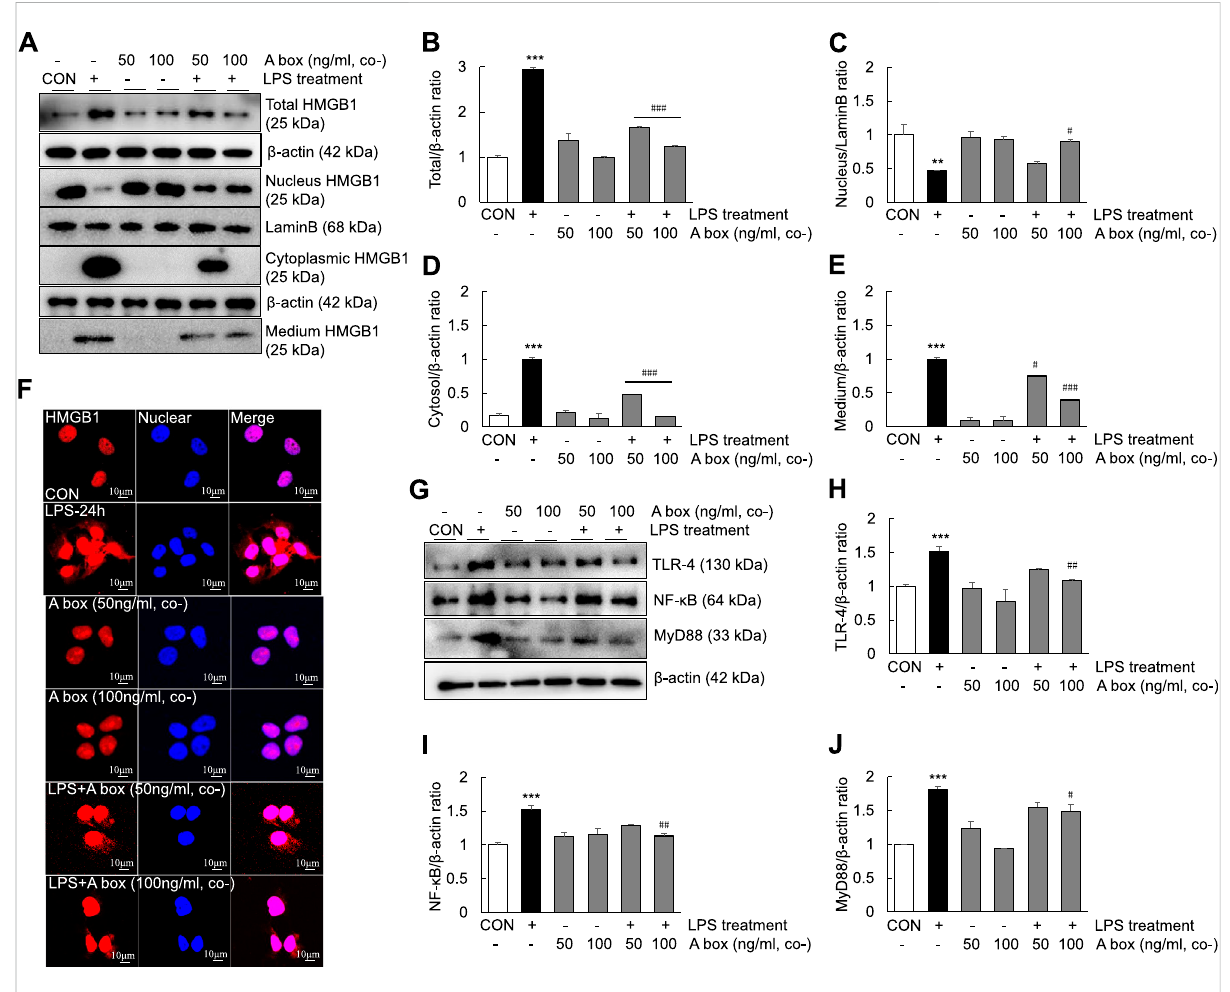
FIGURE 8 Suppression of the extracellular release of HMGB1 and TLR-4/NF- κ B signaling in LPS-induced Huh7 cells following HMGB1-A box treatment. Huh7 cells were treated HMGB1-A box (50 and 100 ng/ml) only for 24 h without LPS treatment and LPS (1000 ng/ml) for 24 h with or without HMGB1-A box (50 and 100 ng/ml). Western blotting was performed to determine the total, nuclear, cytoplasmic and extracellular levels of HMGB1 (A – E) .Confocalmicroscopy wasperformedusing anti-HMGB1 antibody andDAPI to determine theextracellularrelease of HMGB1 (F) . Western blottingwasperformed toassessthelevels ofTLR-4,NF- κ BandMyD88 (G – J) .* p < 0.05, ** p < 0.01vs.control, # p < 0.05, ## p < 0.01, ### p < 0.001 vs. LPS